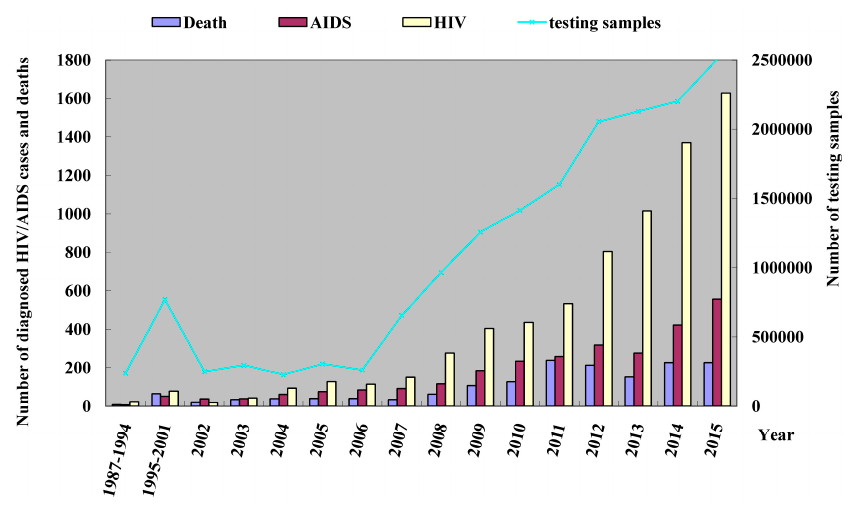
Figure 1. Temporal distribution of HIV/AIDS patients reported in Fujian Province from 1987 to 2015.